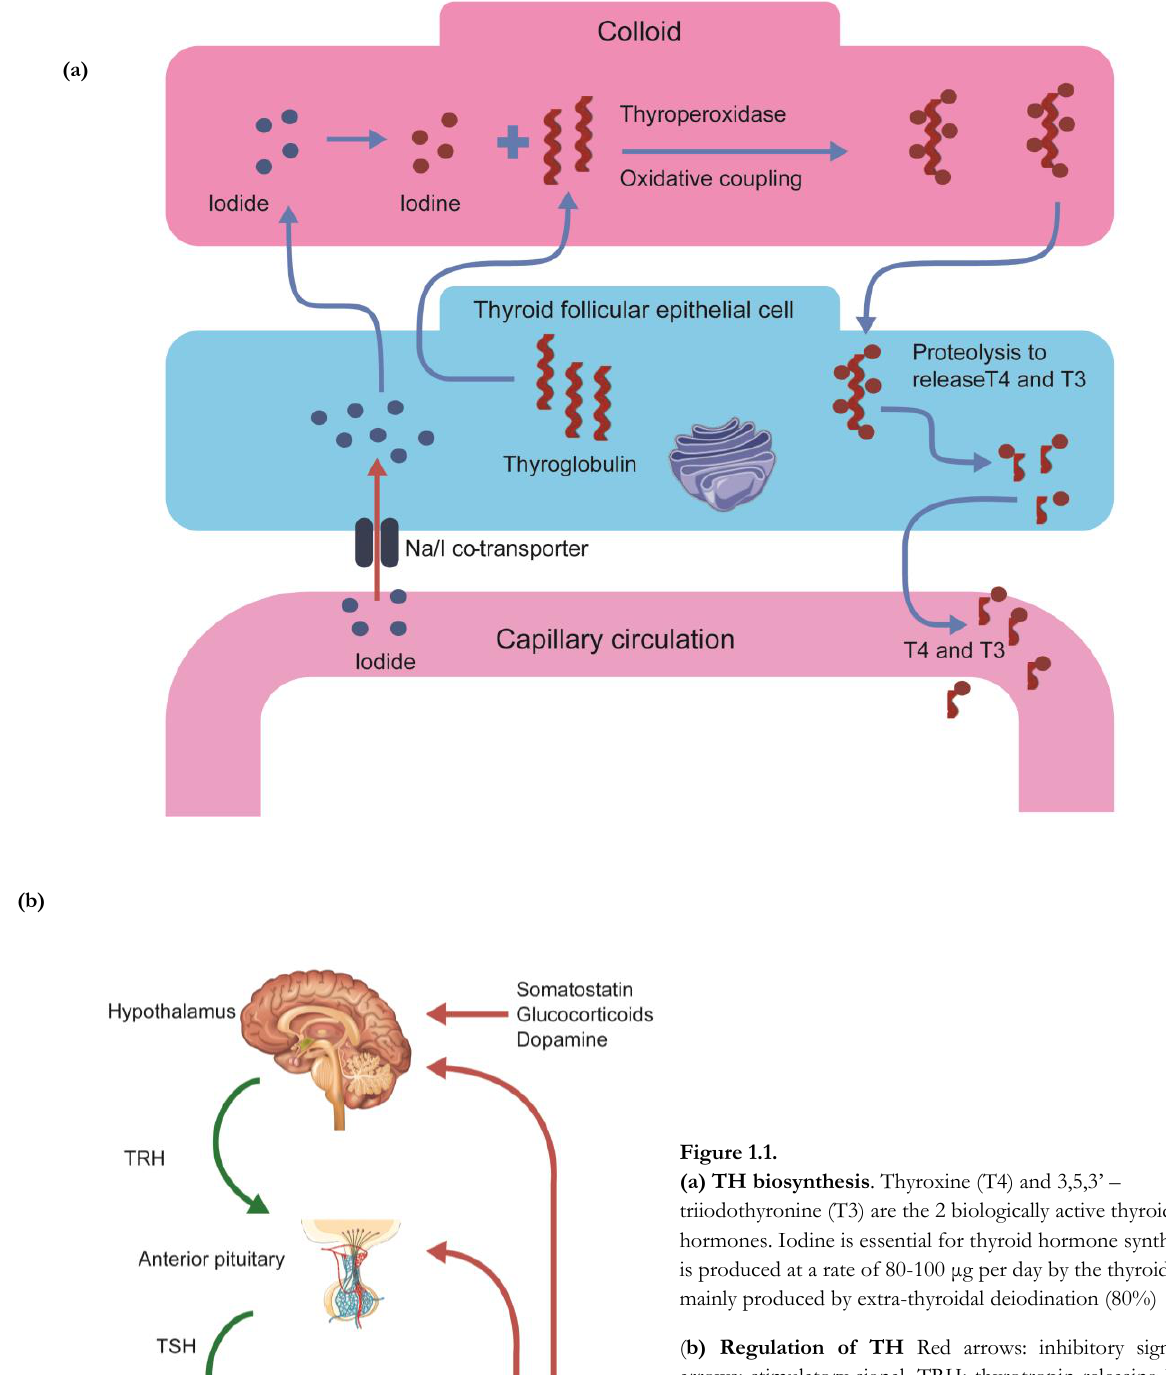
Figure 1.1. (a) TH biosynthesis . Thyroxine (T4) and 3,5,3’ – triiodothyronine (T3) are the 2 biologically active thyroid hormones. Iodine is essential for thyroid hormone synthesis. T4 is produced at a rate of 80-100 μg per day by the thyroid. T3 is mainly produced by extra-thyroidal deiodination (80%) ( b) Regulation of TH Red arrows: inhibitory signal, green arrows: stimulatory signal. TRH: thyrotropin releasing hormone, TSH: thyroid stimulating hormone, T3: tri-iodothyronine, T4: tetra-iodothyronine (thyroxine) Note: TSH has 2 subunits; α and β. α-subunit is similar to LH, FSH and hCG and β-subunit is unique to